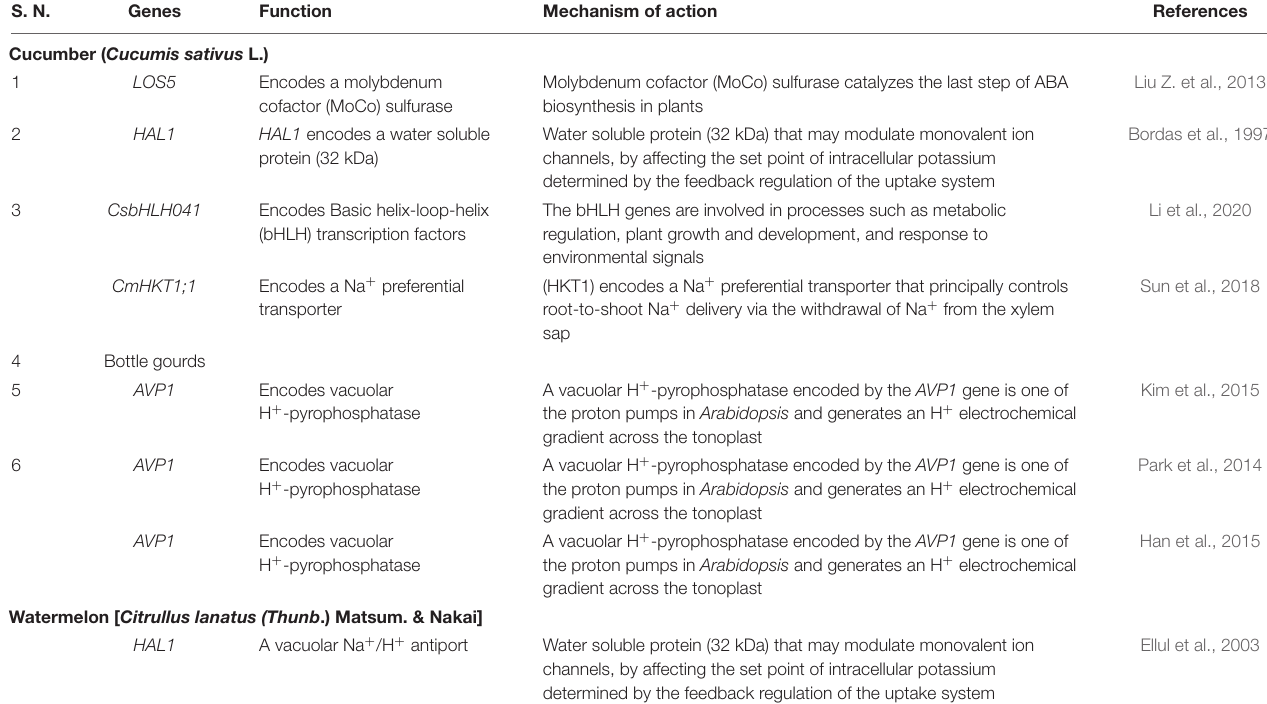
TABLE 2 | Transgenic crops developed in vine crops for salt stress tolerance. S.